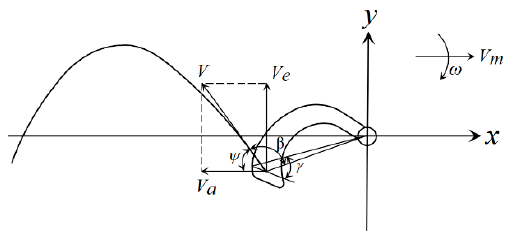
Figure 3. Soil lifting trajectory analysis of rotary tillage cutter.